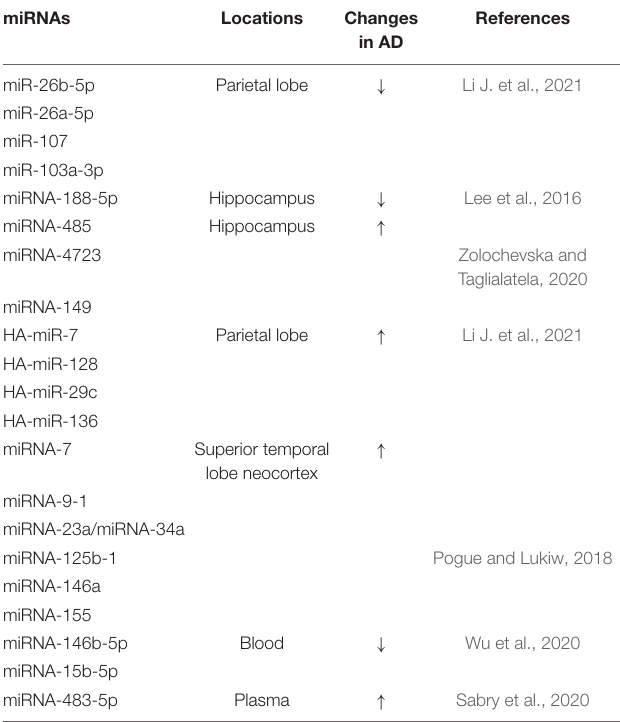
TABLE 1 | Localization and changes of partial miRNA expression in patients with AD and related models. miRNAs